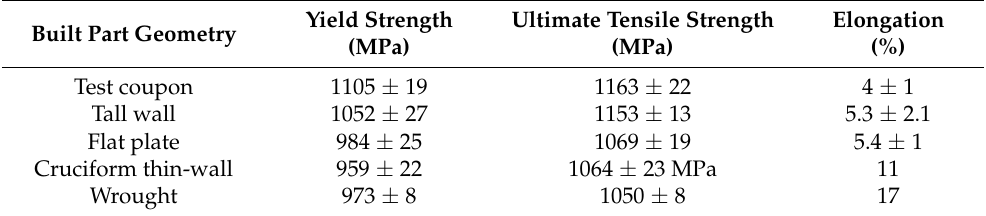
Table 4. Summary of relevant Ti-6Al-4V mechanical properties by LMD process during the tensile axis was along longitudinal orientation